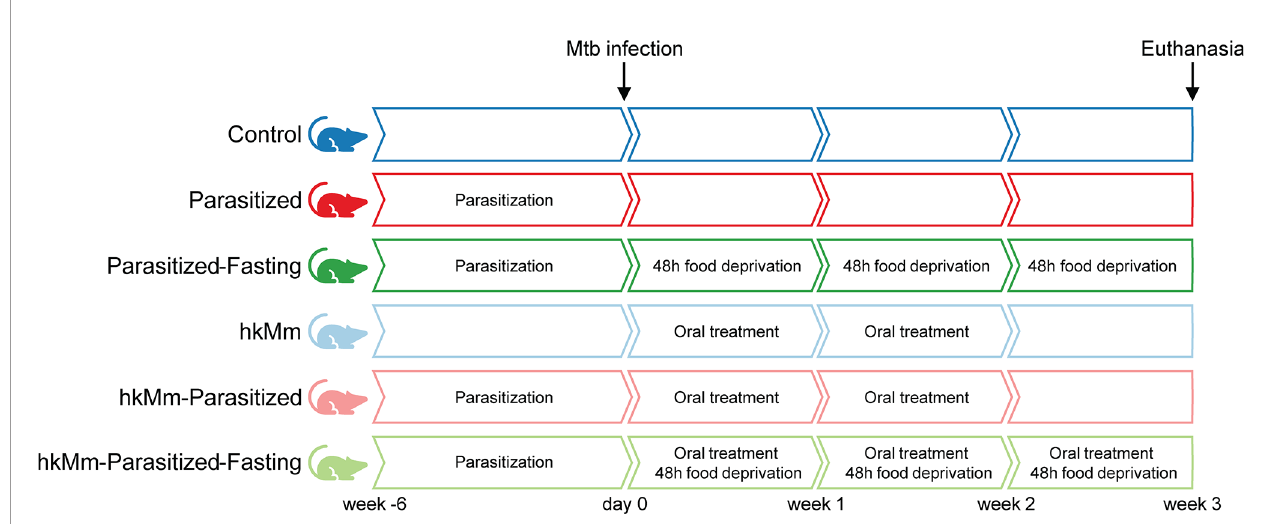
FIGURE 1 | Experimental design. Six groups of 10 animals were used to evaluate the in fl uence of intestine parasitization, intermittent fasting and oral exposure to environmental mycobacteria in an active TB